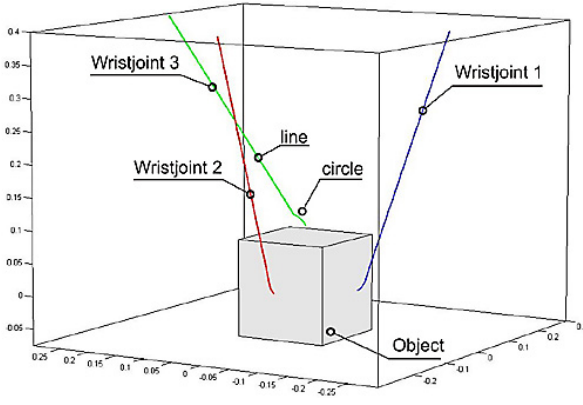
Figure 17. Visualization of the computed grasp